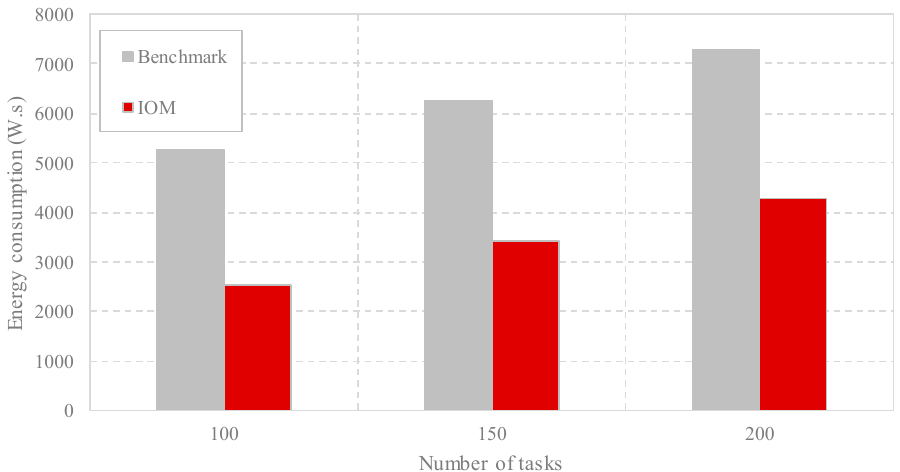
Figure 8. Comparison of the energy consumption with different task scales by Benchmark and IOM.